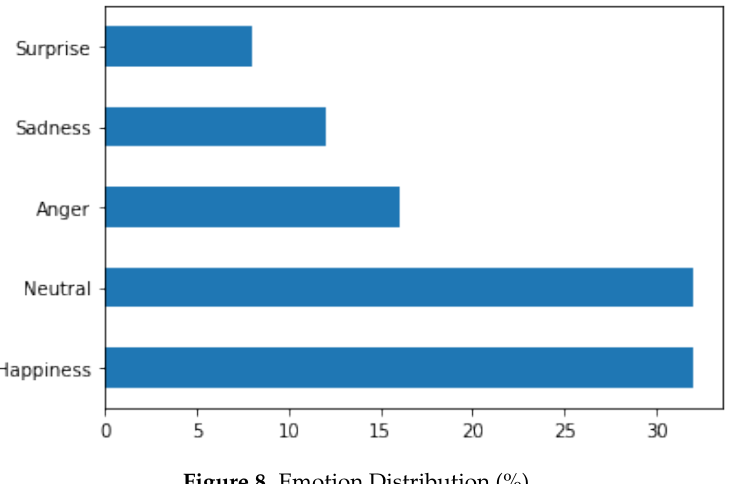
Figure 8. Emotion Distribution (%).